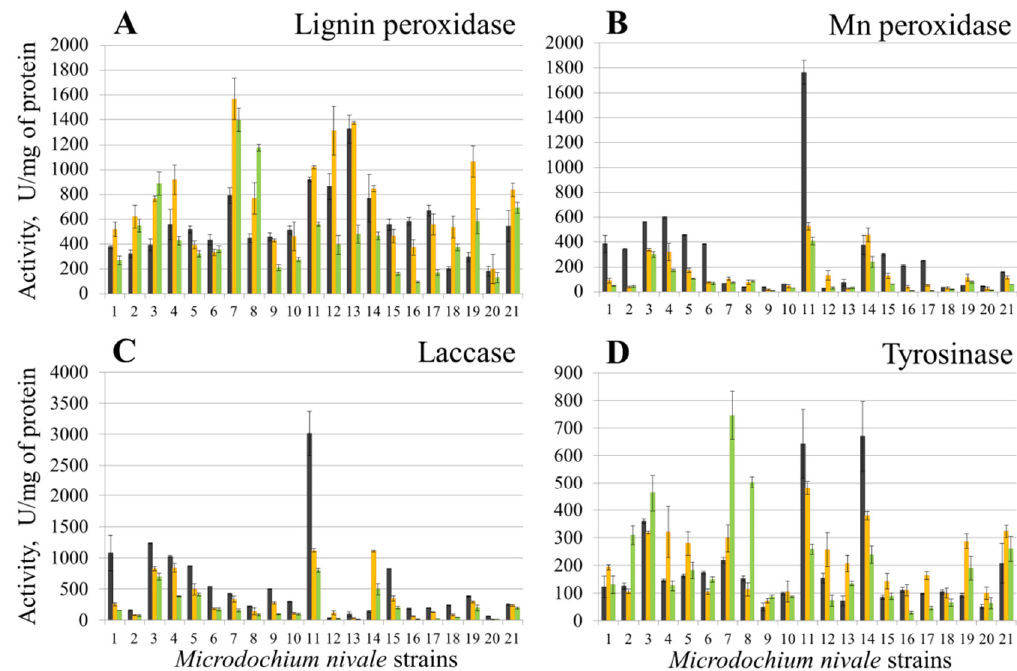
Figure 2. Extracellular lignin peroxidase ( A ), Mn peroxidase ( B ), laccase ( C ), and tyrosinase ( D ) activities of the Microdochium nivale strains grown in minimal medium. Black columns —10 days of cultivation, orange columns—20 days of cultivation, green columns—30 days of cultivation. The presented values are averages ± SD of three biological replicates.